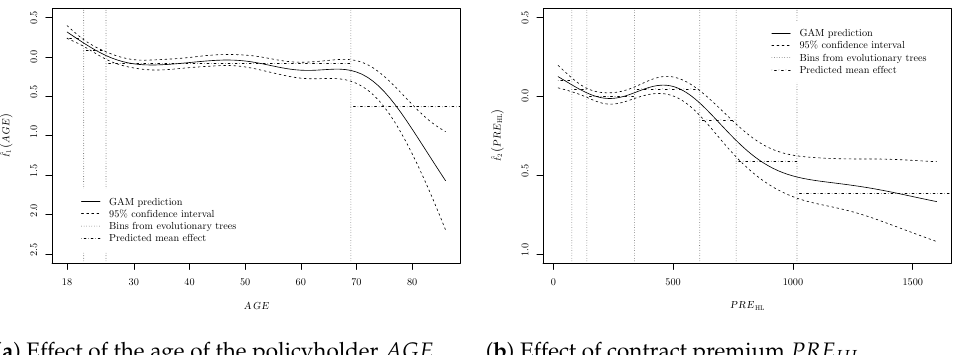
( b ) Effect of contract premium PRE HL . Figure 8. Illustration of the prediction effect from the Cox model ( ˆ f 1 and ˆ f 2 ) in Equation (7) and of the bins obtained from evolutionary trees for the age of the policyholder AGE and the contract premium PRE HL in the HL cohort.